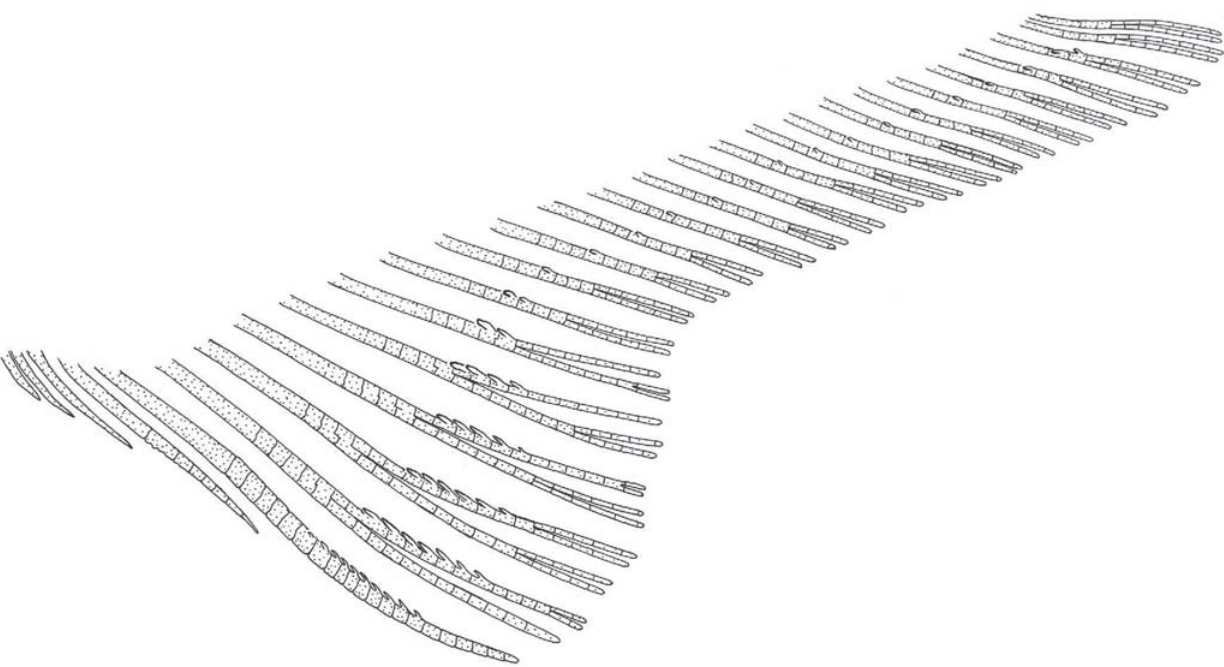
Fig. 15. Glandulocauda melanopleura , adult male, USNM 236093, 40.2 mm SL; osteology of caudal skeleton and caudal-fin squamation of dorsal portion of caudal-fin lobe (lower left insert), lateral view, left side, anterior at left. Modified from Menezes & Weitzman (1990).